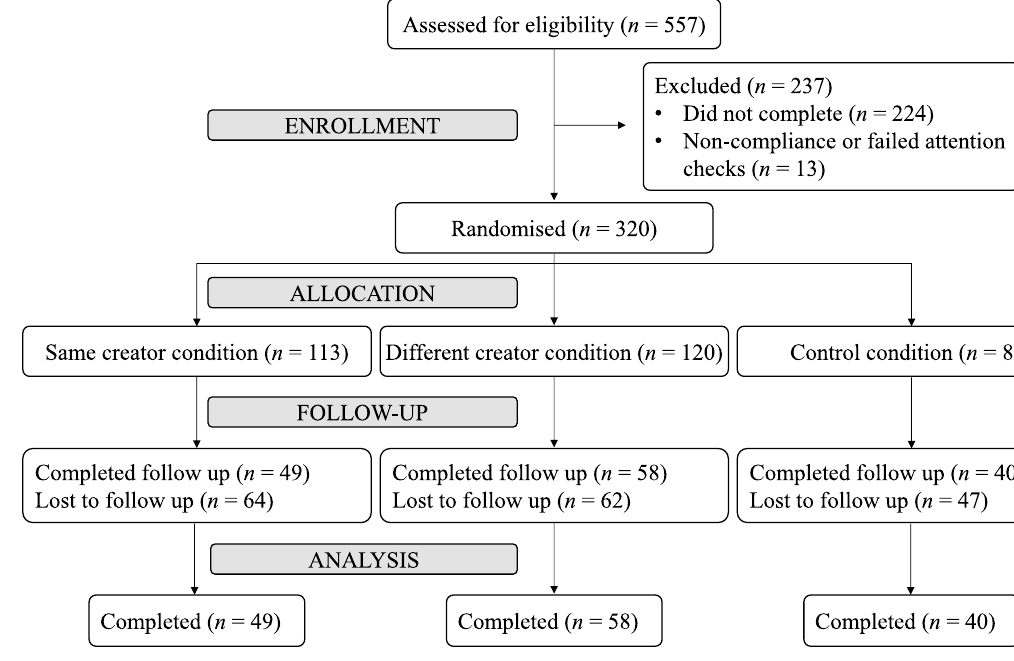
Figure 1. Diagram of participant flow.